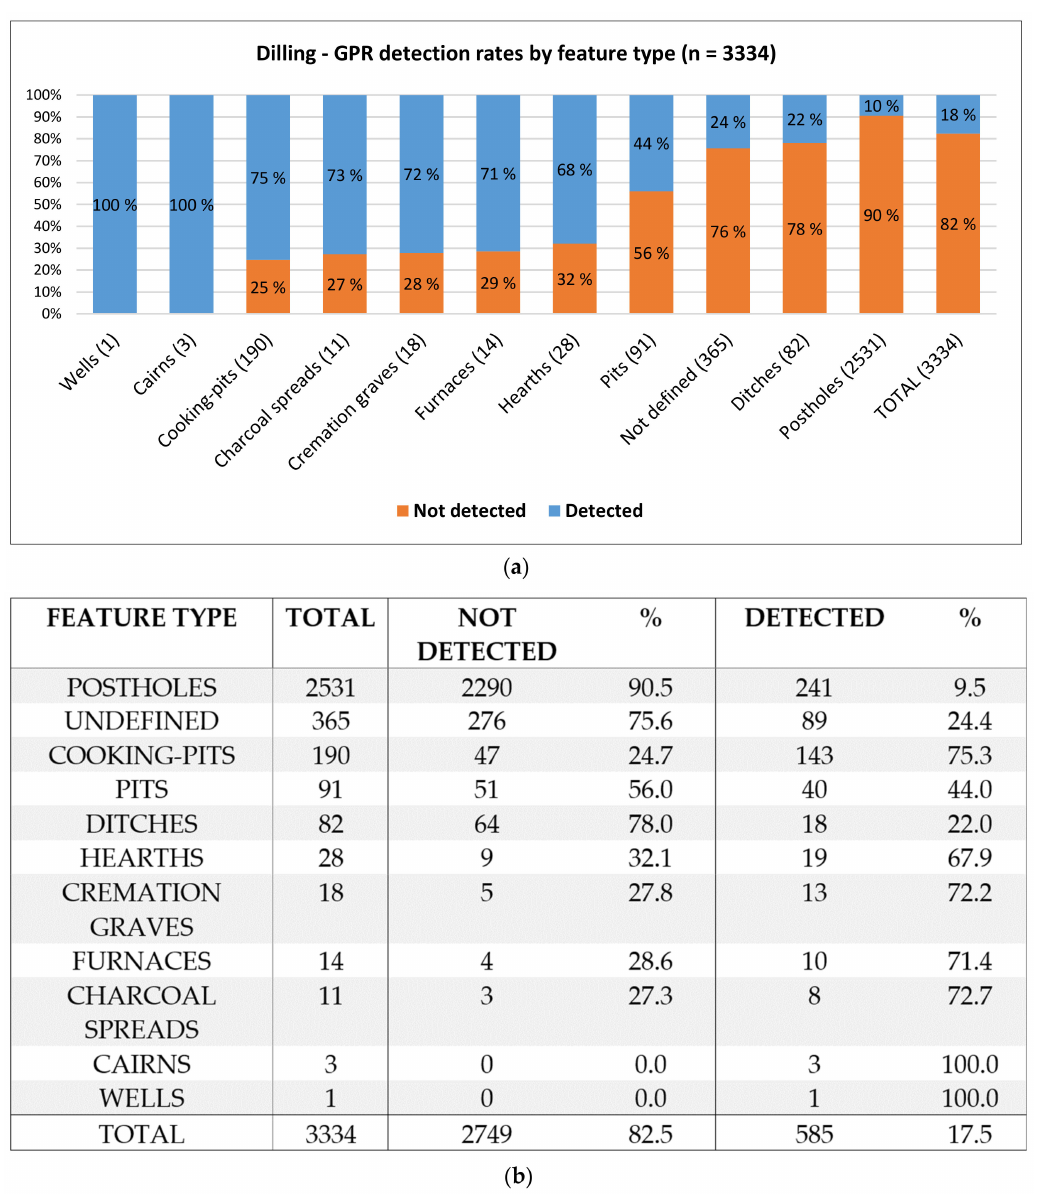
Figure 12. ( a , b ) Charts showing the GPR detection rate by feature type at Dilling. Table 4. The calculated spatial correlation between